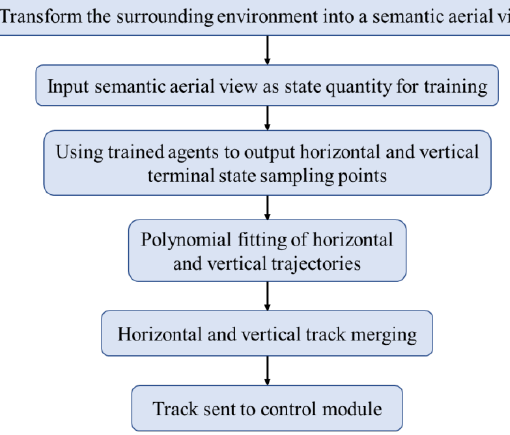
Figure 7. Lattice sampling process improvement.